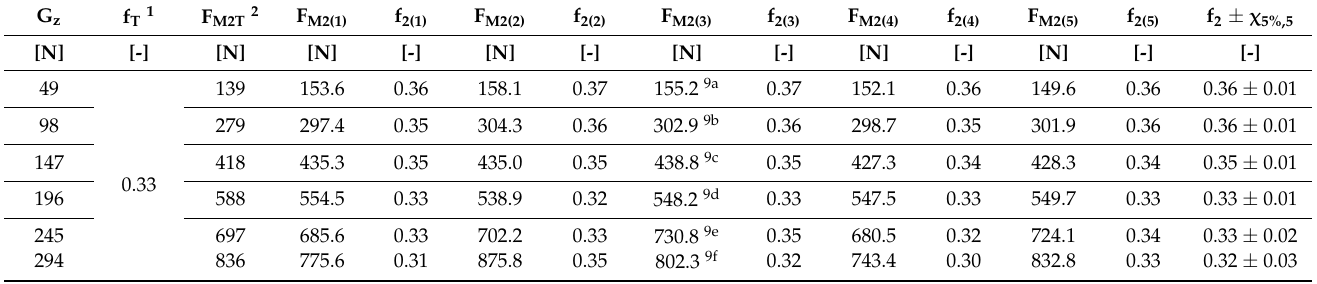
Table 9. Tensile force F M2(i) [N], φ 6 mm rope, V-shaped groove, γ = 35 deg, contaminated with oil.